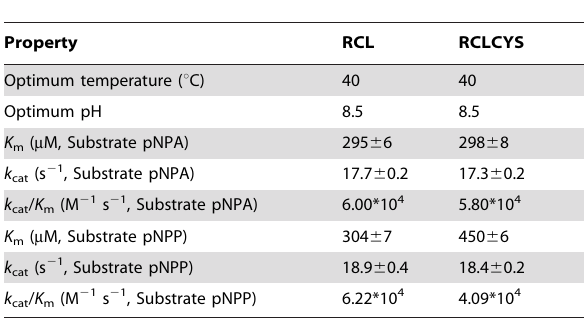
Figure 6. Solvent-free conversion of soy bean oil to fatty acid methyl esters by RCLCYS and RCL at different temperatures. The various curves refer to the conversion of soy bean oil by lipases as a function of temperature at different intervals of reaction time.